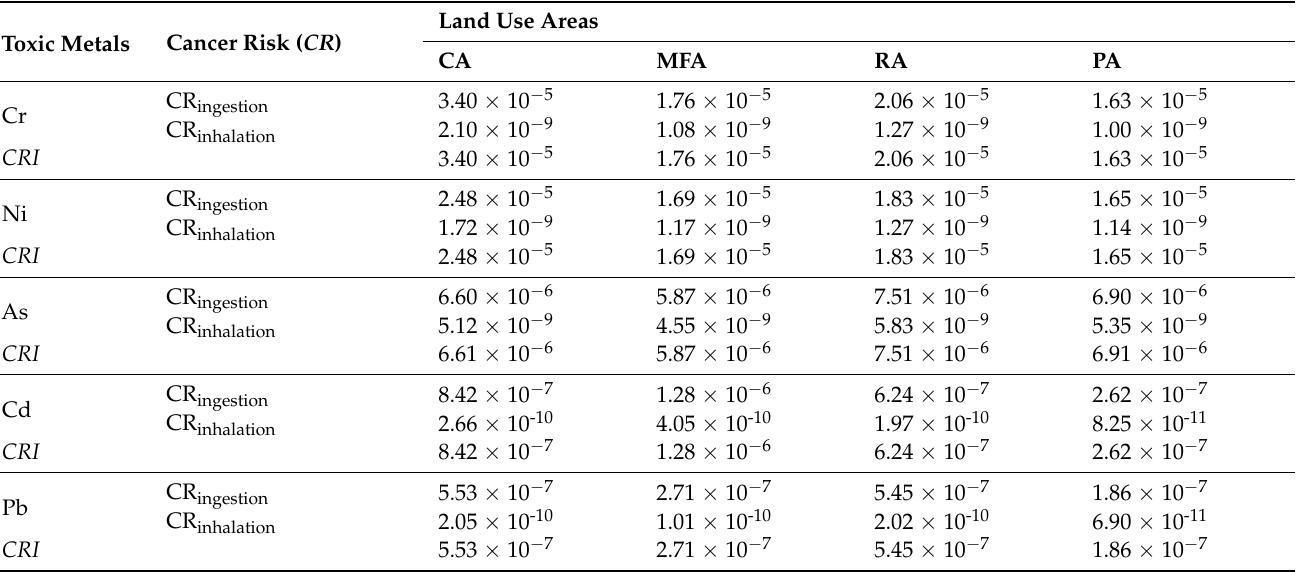
Table 5. Carcinogenic risk ( CR ) and cumulative cancer risk index ( CRI ) of toxic metals in different land use areas in Mymensingh